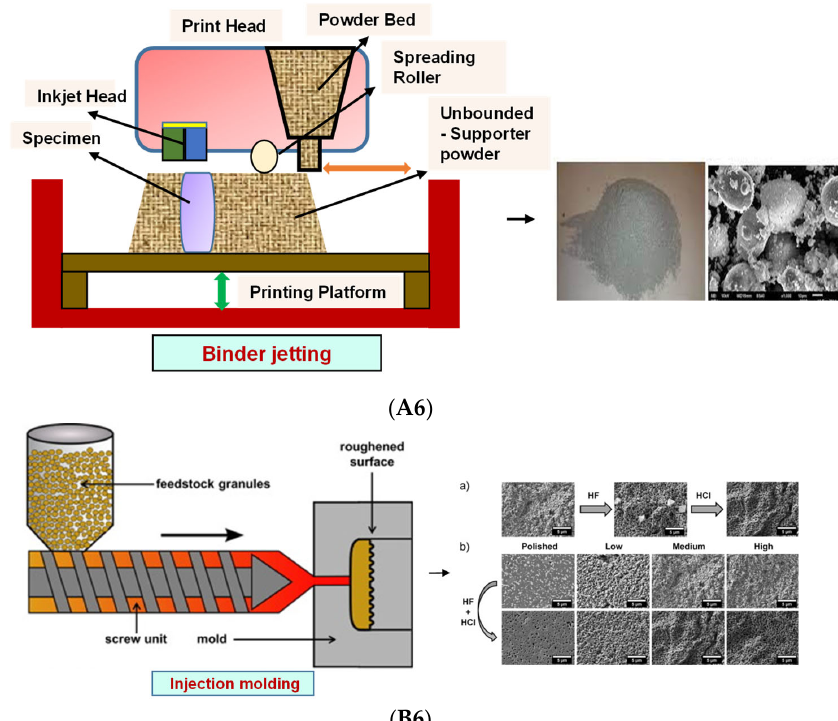
Figure 6 . ( A6 ) Schematic illustration and scanning electron microscope images of BJ. Reprinted with permission from Ref. [125], Copyright 2021, CSI; SS316 ‐ Tricalcium phosphate (left) and its morphology (right). Reprinted with permission from Ref. [126], Copyright 2017, Conference Reviewed Paper. ( B6 ) Schematic representation of injection molding and ( a ) microscopic observations of the surface of zirconia toughened alumina at the various steps of the selective etching process, demonstrating the formation of fluoride precipitates during hydrofluoric acid etching and their subsequent removal in HCl; ( b ) FE ‐ SEM observations of the surface of injection molded samples with different surface topographies before and after selective etching. Low, Medium and High surfaces attained from increasingly rough molds. Polished entitles the surface of samples that were polished after sintering. Scale bars: 5 μ m. Reprinted with permission from Ref. [127], Copyright 2016, Elsevier Ltd.